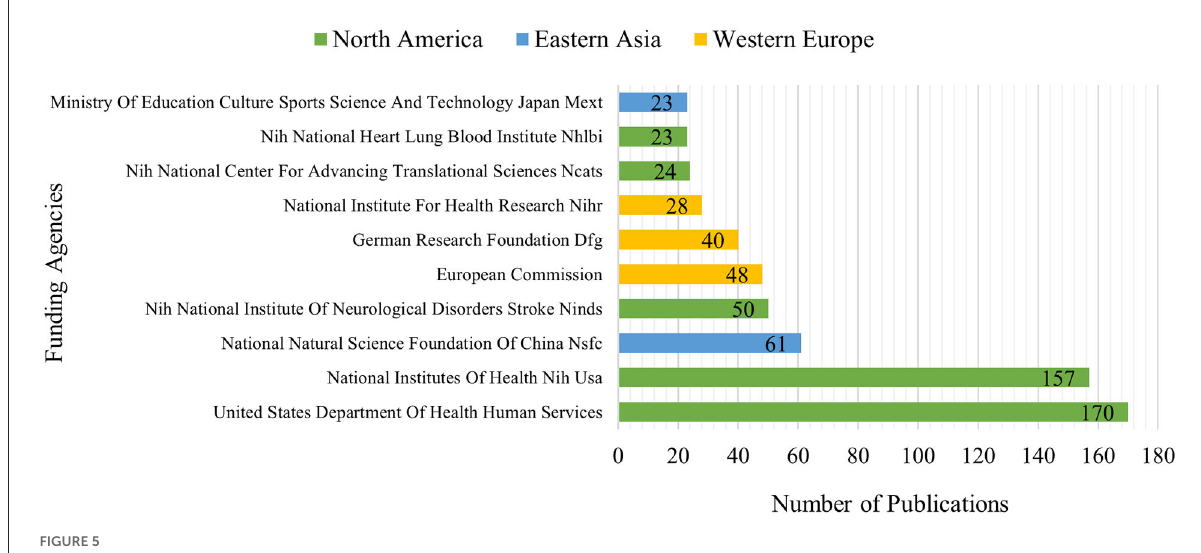
FIGURE5 The top 10 funding agencies for the output in the post-stroke pneumonia field.